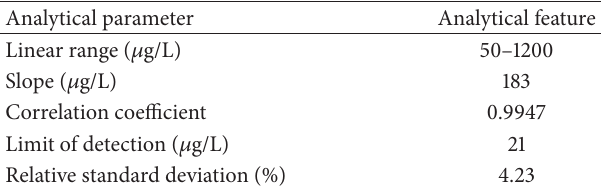
Figure 6: Effect of HCl concentration on the extraction recovery of Sr 2+ . Table 1: Linear range, limit of detection, and repeatability of the method.